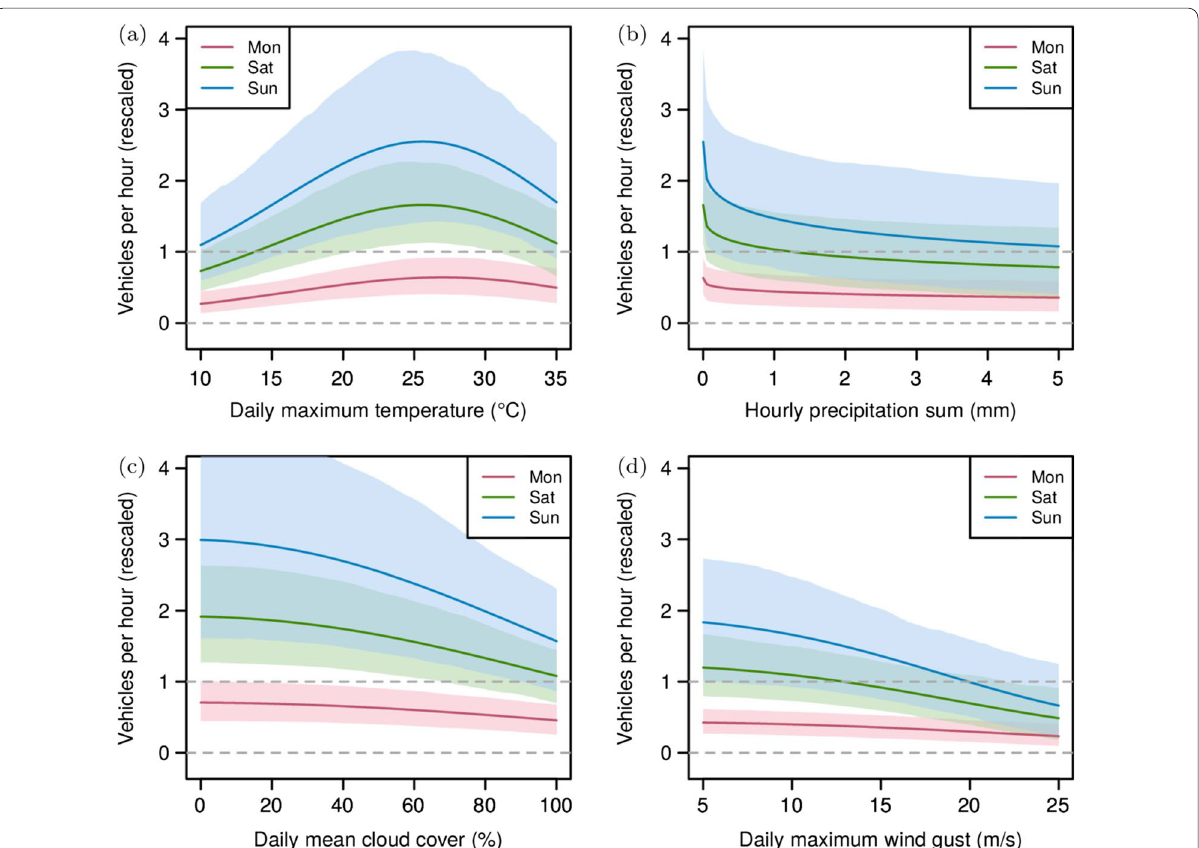
Fig. 6 Modeled rescaled motorbike counts on federal roads. Modeled motorbike counts are shown as a function of different meteorological parameters and different days of the week. While one predictor variable is varied, all other variables are held constant (see Table 6). Thick lines represent the mean value of all traffic stations. The shaded area indicates the 0.1 and 0.9 quantile of the values of all traffic stations. The gray dashed lines at 0 and 1 indicate the average daily minimum and maximum of motorbike counts, which is used for the rescaling